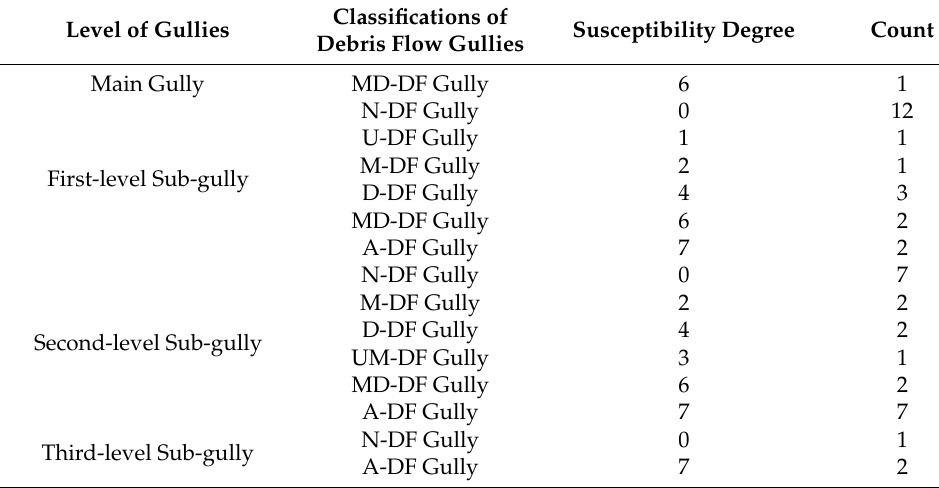
Table 3. Statistics of different debris flow gullies in the JJG. Level of